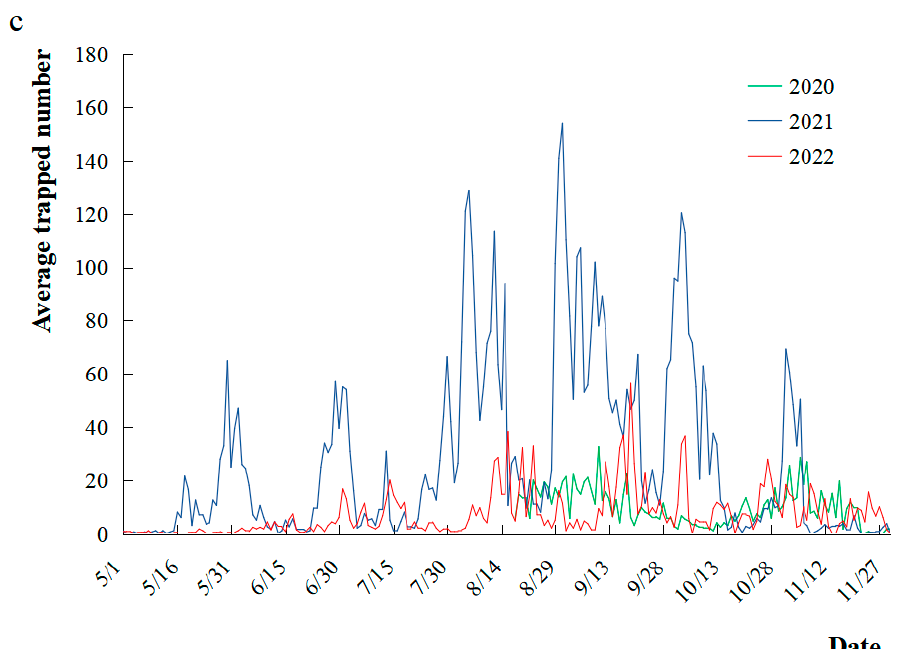
Figure 8. Trapping dynamics of S. litura male moths in different months. ( a ) The total number of S. litura male moths and monthly average temperature and humidity monitored by AIM; ( b ) the total number of S. litura male moths and the averages of daily light duration and maximum light intensity in a month monitored by AIM; ( c ) the daily trapped number of male moths during the occurrence period of S. litura after AIM installation.